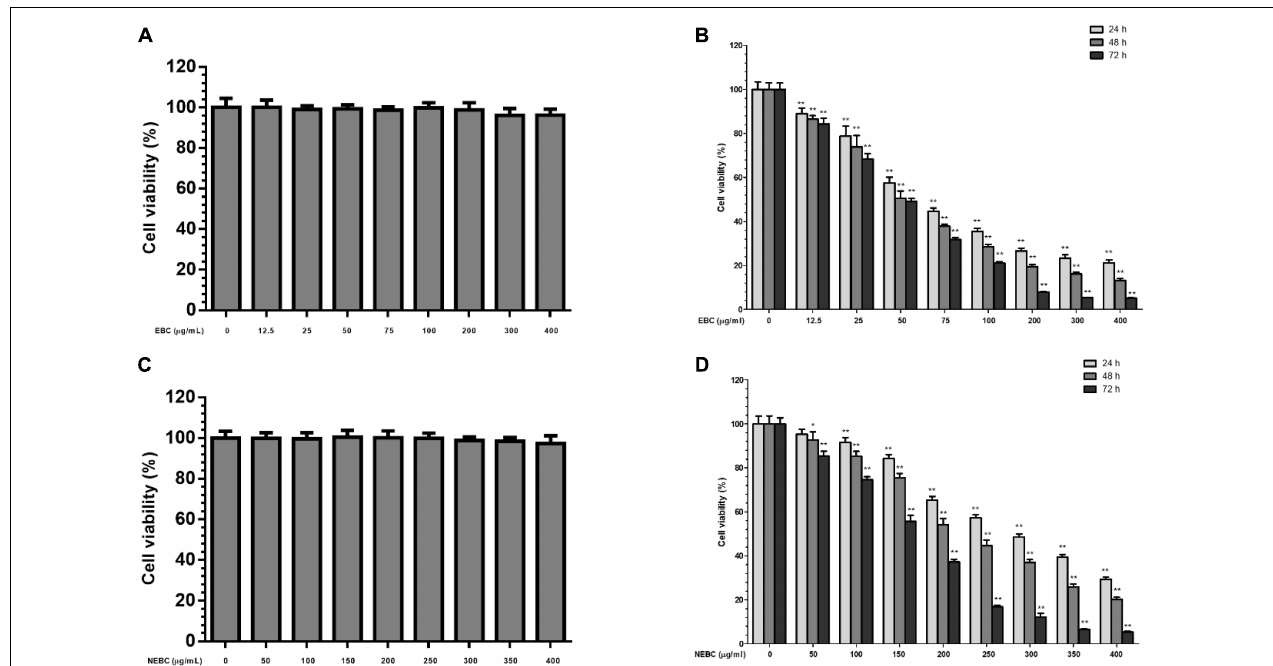
FIGURE 2 | Effects of EBCs (A) and NEBCs (C) on the growth of CCD18-Co cells for 72 h; Inhibitory effects of EBCs (B) and NEBCs (D) on the growth of HCT116 cells for 24, 48, and 72 h. * indicates P < 0.05 and ** indicates P < 0.01, when compared to the untreated control